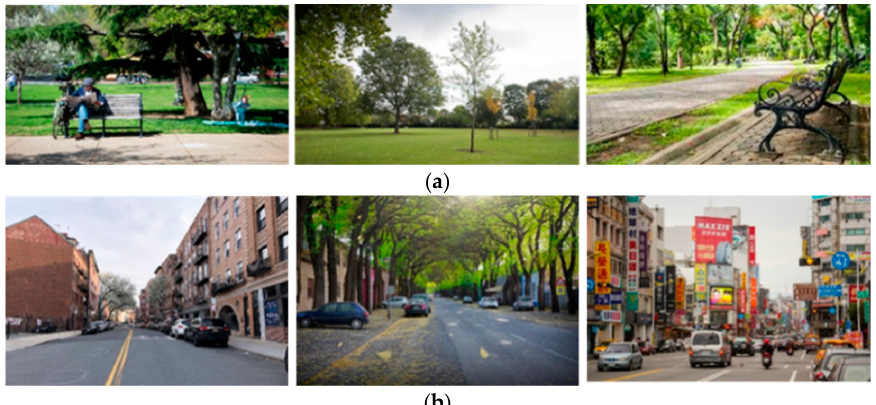
Appl. Sci. 2022 , 12 , x FOR PEER REVIEW Figure 9. ( a ) First set of images ; ( b ) second set of images. Figure 9. ( a ) First set of images; ( b ) second set of images.